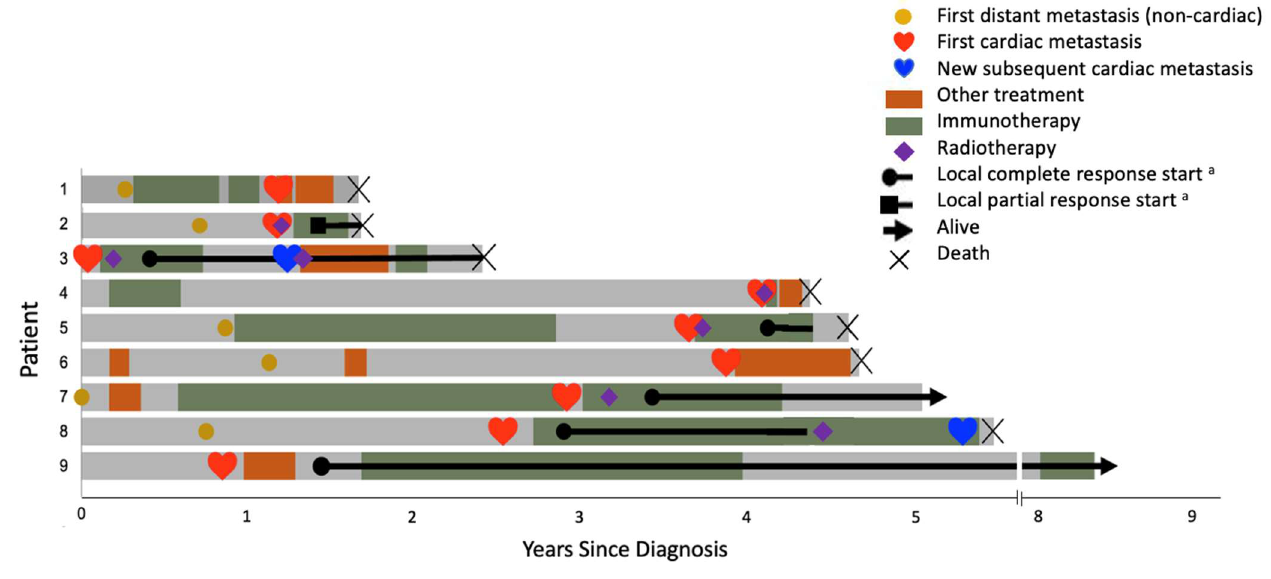
Figure 2. Swimmer plot of the clinical course of each patient. Swimmer plots with each lane repre- senting an individual patient’s disease trajectory, the timing of cardiac metastasis, treatment, and kinetics of response and disease progression. The heavy black lines represent responses to cardiac metastasis-directed treatment. Patient #3 developed the new subsequent cardiac metastasis outside the radiation field in the left side of the heart and did not recur in the initial treated cardiac lesion. The clinical course of this patient is described in Figure 1. Patient #8 received immunotherapy without radiation. Although Patient #8 achieved complete response including the initial lesion in the right side of the heart, the patient had a local cardiac recurrence about 2 years later and eventually developed a new metastasis in the left side of the heart. (a) Local response at the treated 1st cardiac mMCC.